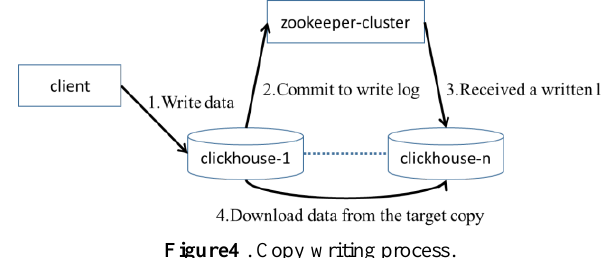
Figure4 . Copy writing process.